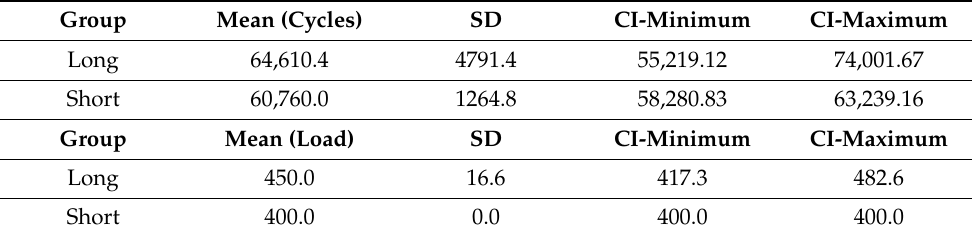
Table 4. Mean and standard deviation during fatigue according to the cycles to failure and load to failure for both groups.